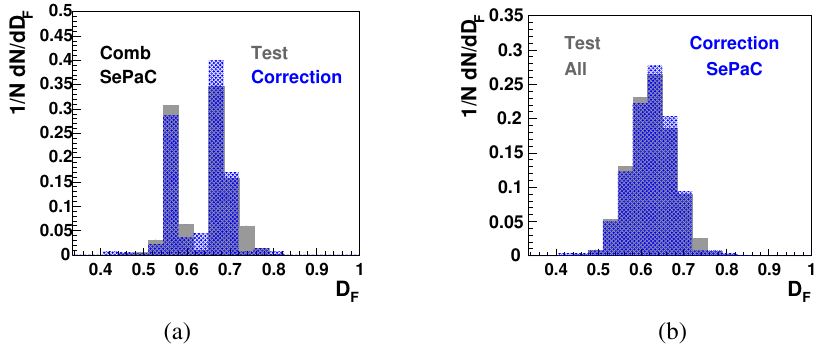
Figure 5. The event distributions by dimension D F for combined fractals (a) and the full data set (b). The gray and blue areas correspond to the test and reconstructed distributions using the SePaC method after the correction,